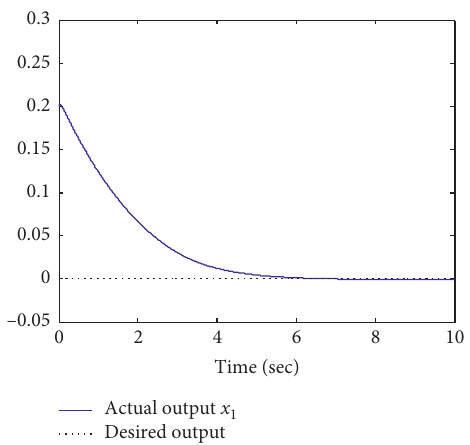
Figure 5: Trajectories of the first output x [45].